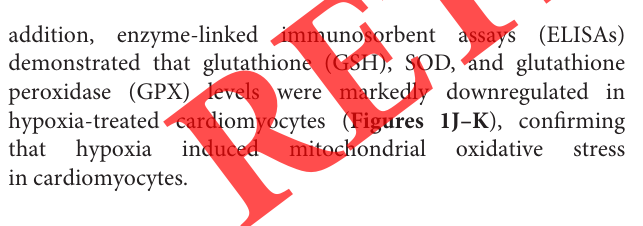
FIGURE 2 | The mtROS/JNK pathway induces cardiomyocyte death. (A,B) Western blotting was used to analyze phosphorylated JNK levels in cardiomyocytes subjected to hypoxia. The mtROS neutralizer mitoQ was used to attenuate mtROS levels in cardiomyocytes. (C,D) An immunofluorescence assay was used to detect phosphorylated JNK levels in cardiomyocytes subjected to hypoxia. (E) Cardiomyocyte viability was measured using a CCK-8 assay. (F) An ELISA was used to analyze caspase-3 activity in cardiomyocytes subjected to hypoxia or treated with mitoQ. * p < 0.05 vs. control